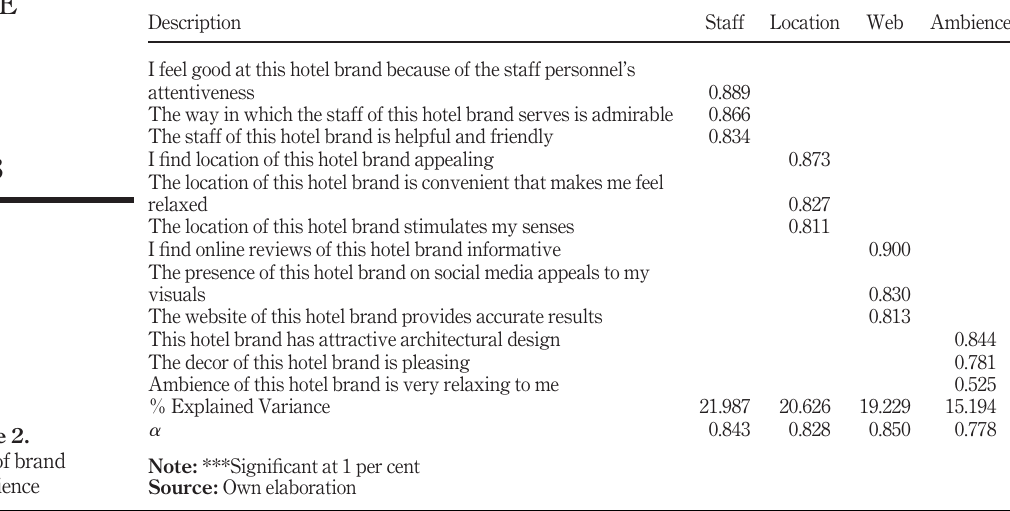
Table 2. PCA of brand